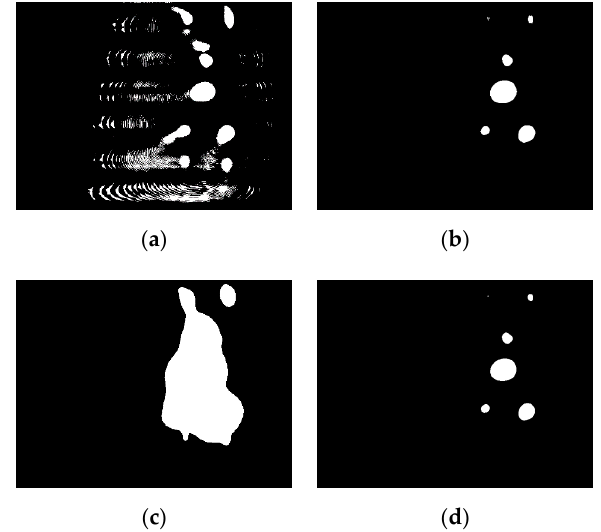
Figure 7. The threshold segmentation results of the four TSM: ( a ) Adaptive local TSM; ( b ) Pre-specified TSM, set T as 125; ( c ) Traditional OTSU TSM, T = 48; ( d ) Adaptively weighted OTSU TSM, T = 128.